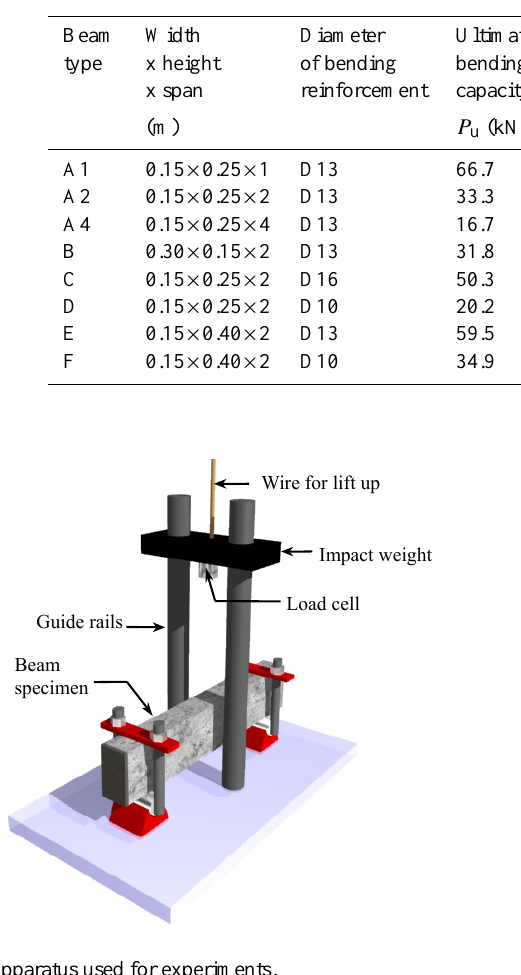
Table 1. Design values of reinforced concrete beams.